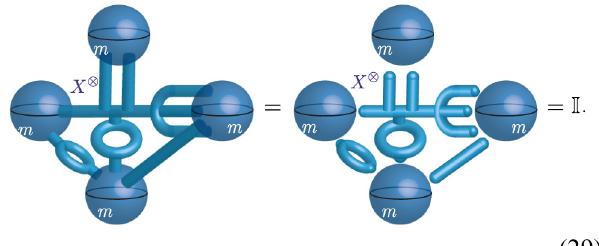
Fig. 20. The whole X -brane can be locally deformed into vacuum as shown in the